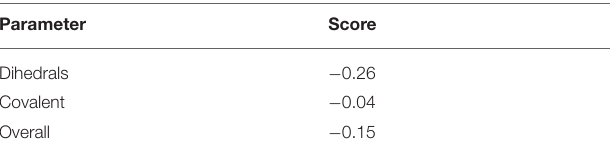
TABLE 3 | PROCHECK projected statistics of the proposed three-dimensional model.